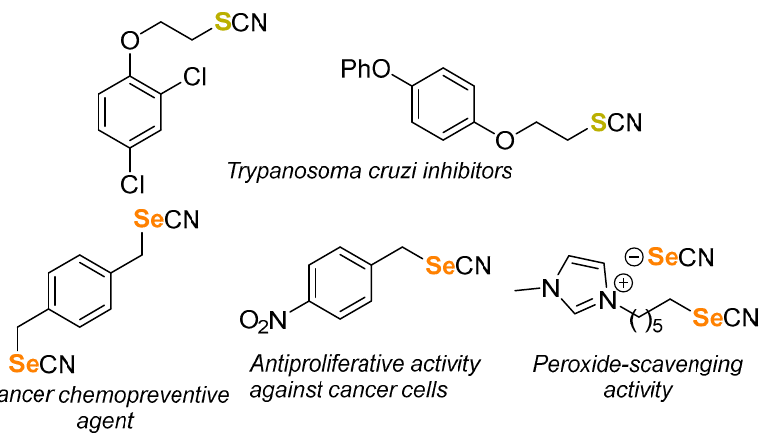
Figure 1. Structure of biologically active organothiocyanates and organoselenocyanates.